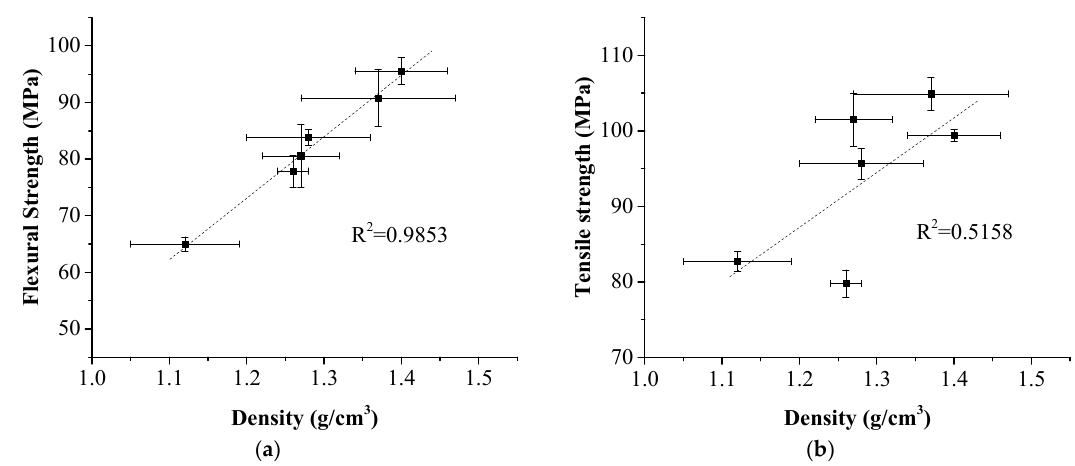
Figure 7. Relationship between density and mechanical strength of the laminated composites. ( a ) flexural strength; ( b ) tensile strength.